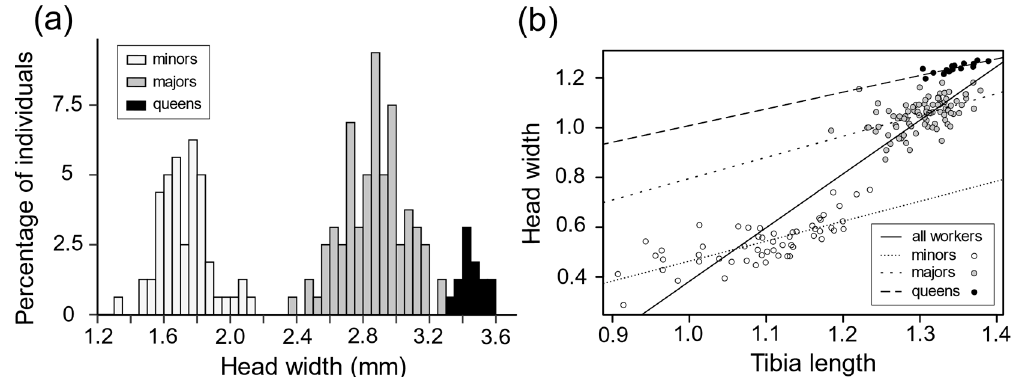
Figure 1. ( a ) Distribution of worker and female reproductive (queens) head width based on measurements from 157 workers (60 minors and 97 majors) originating from 4 colonies and from 15 female reproductive out of one colony. ( b ) Relationship between head width and tibia length based on measurements from 143 workers (55 minors and 88 majors) and 15 queens. The two variables were natural log-transformed. When the measurements for the two worker subcastes were combined (solid line), the regression analysis revealed the presence of allometry (linear regression: slope ± SE = 2.07 ± 0.07, F 1,142 = 809.3, p = 0). In the worker subcaste-specific regressions, the slopes for the minors (line with short dashes) and the majors (line with long dashes) were not significantly different from 1, indicating that there was no further allometry within subcastes (minors: slope ± SE = 0.80 ± 0.10, t test, t = − 1.94, df = 53, p = 0.057; majors: slope ± SE = 0.86 ± 0.16, t test, t = − 0.89, df = 86, p = 0.38).